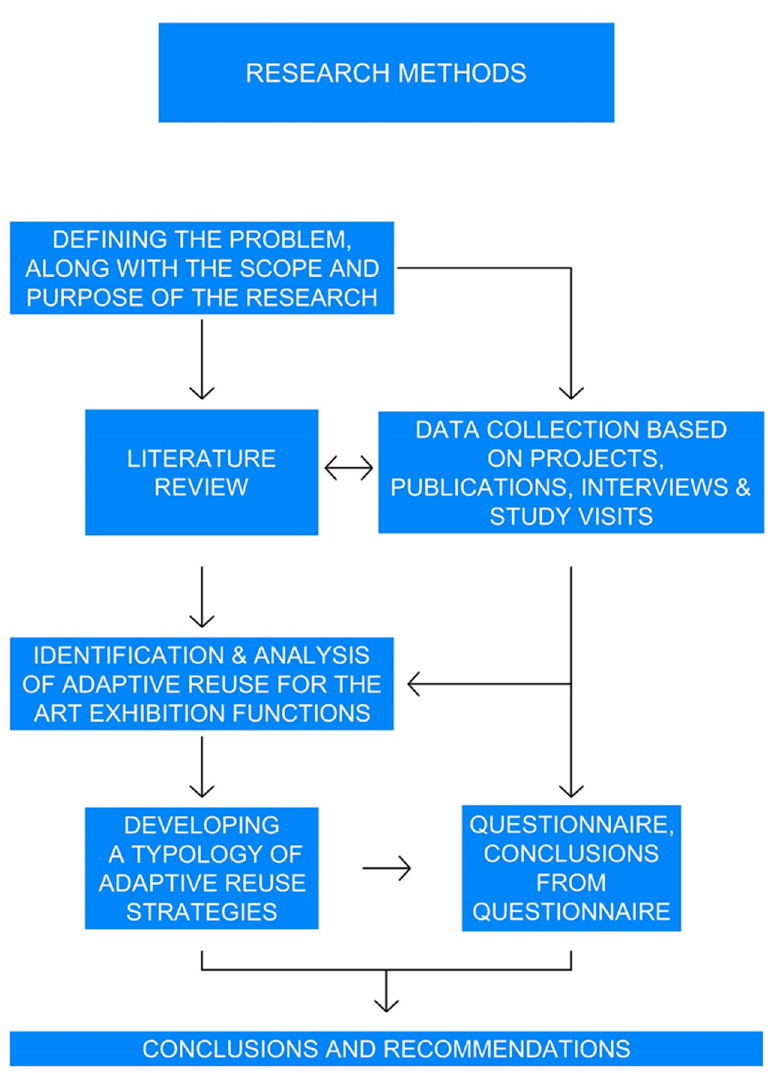
Figure 1. Research methods, authors’